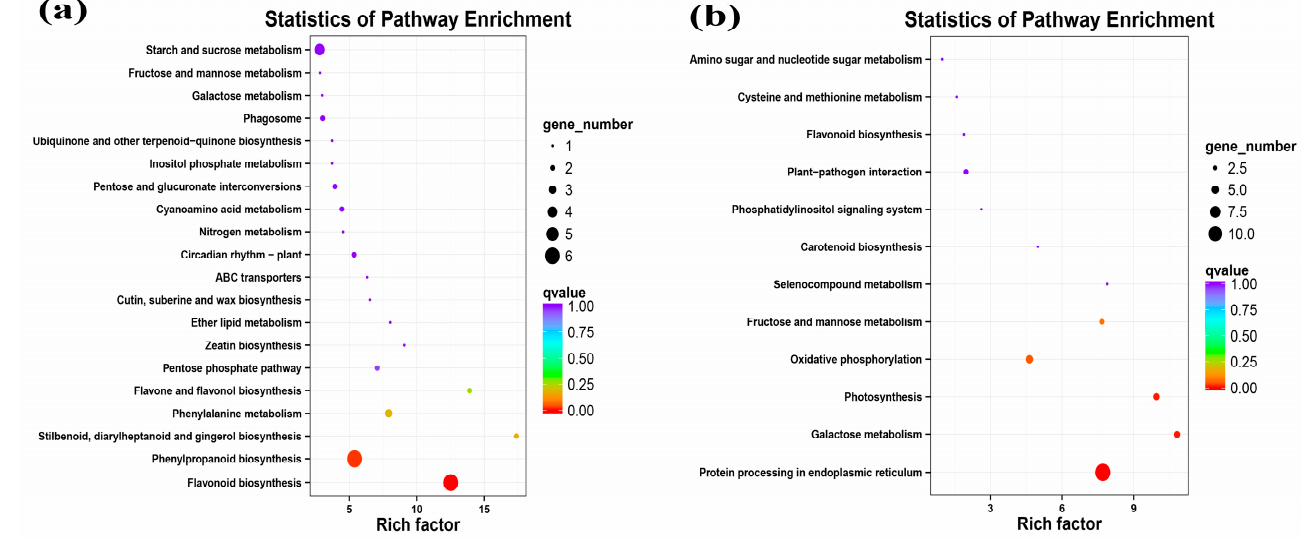
Figure 4. Pathways analysis of differentially expressed genes in leaf. ( a ) KEGG enrichment analysis of up-regulated genes at EL15; ( b ) down-regulated genes at EL15; ( c ) up-regu- lated genes at EL31; ( d ) down-regulated genes at EL31. The size of Bubbles represents the amount of genes, and the color represents the qvalue.